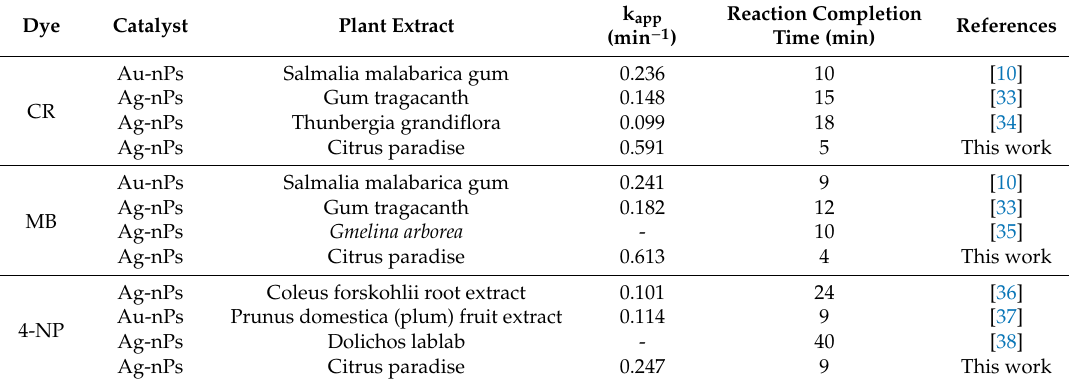
Table 1. Comparative analysis kinetic parameters for catalytic reduction of di ff erent dyes using di ff erent plant extract induced metal